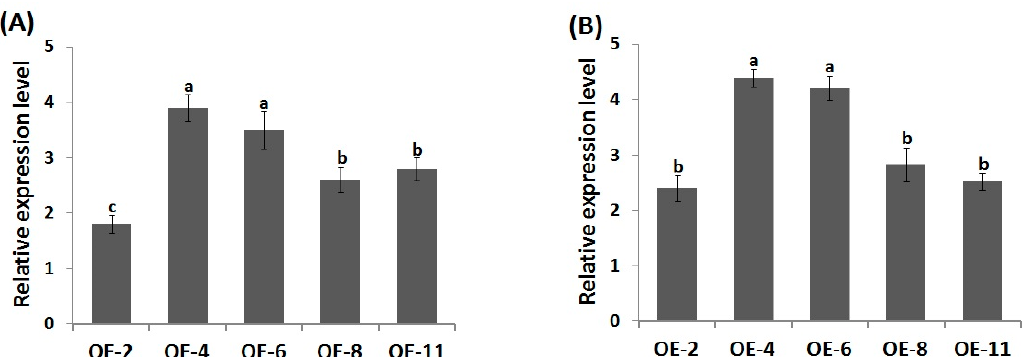
Figure 1. AtWRKY30 relative expression in T 0 ( A ) and T 2 ( B ) overexpressed wheat lines using quantitative real-time PCR (qRT-PCR).